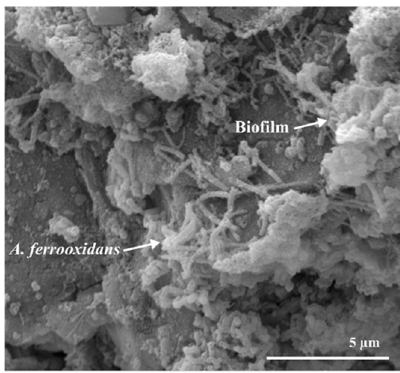
Figure 6. Scanning electron microscope (SEM) micrograph (HV:10.0 kV) showing A. ferrooxidans adhesion and biofilm formation over the sulfide ore particle during column bioleaching.